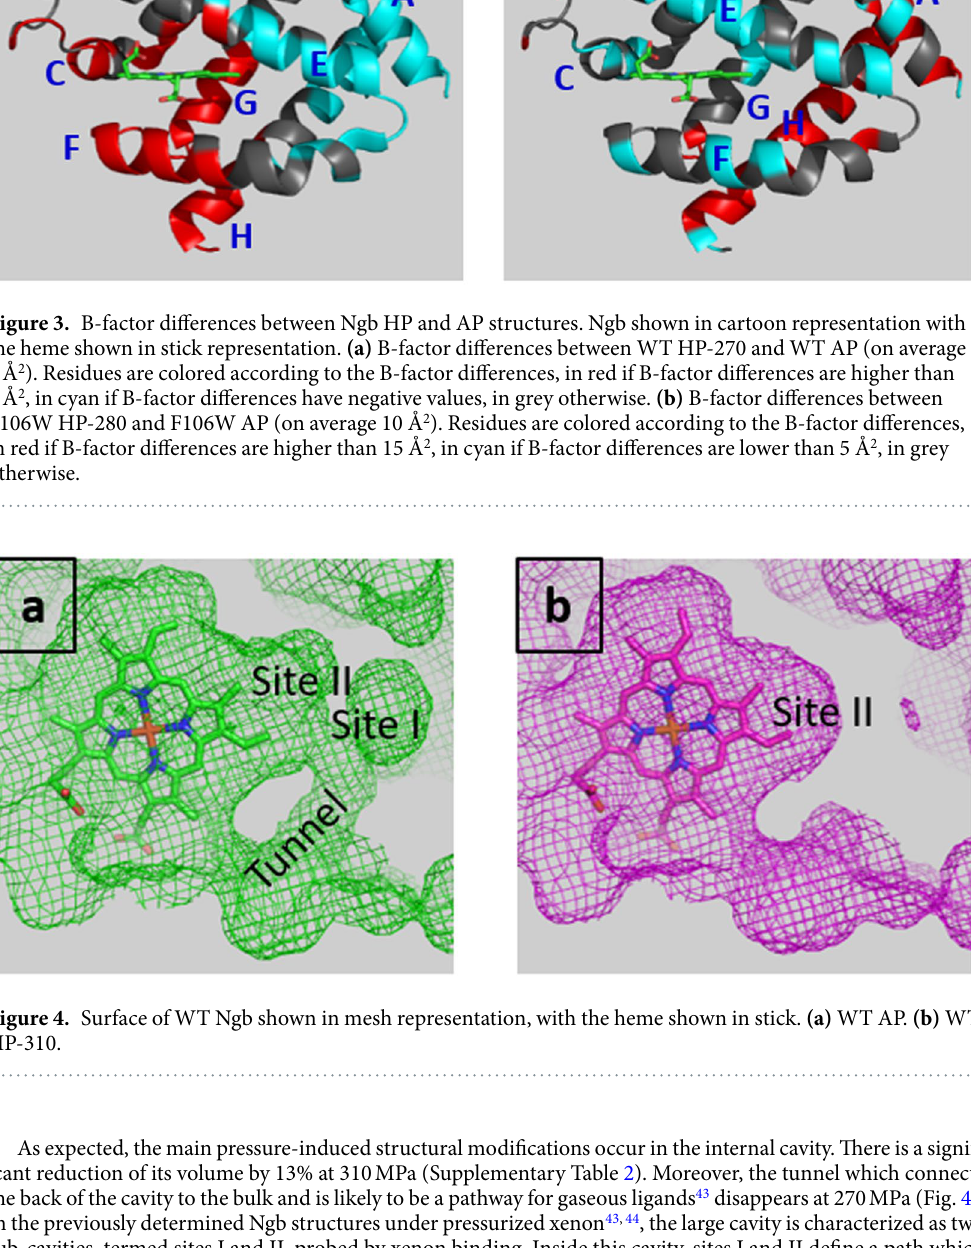
As expected, the main pressure-induced structural modifications occur in the internal cavity. There is a signif- icant reduction of its volume by 13% at 310 MPa (Supplementary Table 2). Moreover, the tunnel which connects the back of the cavity to the bulk and is likely to be a pathway for gaseous ligands 43 disappears at 270 MPa (Fig. 4). In the previously determined Ngb structures under pressurized xenon 43, 44 , the large cavity is characterized as two sub-cavities, termed sites I and II, probed by xenon binding. Inside this cavity, sites I and II define a path which connects the protein surface to the heme distal site. Site I is located at the back of the cavity, close to the tunnel, and site II is located between the heme and site I (Fig. 4a). In the WT HP-270 structures, both sites are still pres- ent, while, in the WT HP-310 structure, site I disappears while site II remains (Fig. 4b). V101F mutant at 150 and 240 MPa - The V101F mutant crystal seems to be more sensitive to pressure than the WT, possibly due to the increased cavity volume and to destabilization of internal packing (Supplementary Fig. 1). There are no significant differences between V101F HP-150 and V101F AP. Comparing V101F HP-240 and V101F AP (or V101F HP-150), the main zones affected by pressure are the FG loop and the beginning of helix G (F101 – G110), which are also the segments mainly affected upon mutation, while helix F is not modified (Figs 1e, 2e).